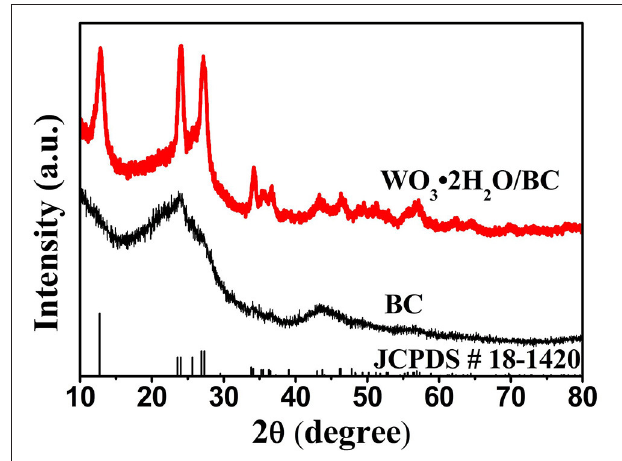
FIGURE 2 | XRD patterns of the BC and WO 3 · 2H 2 O/BC